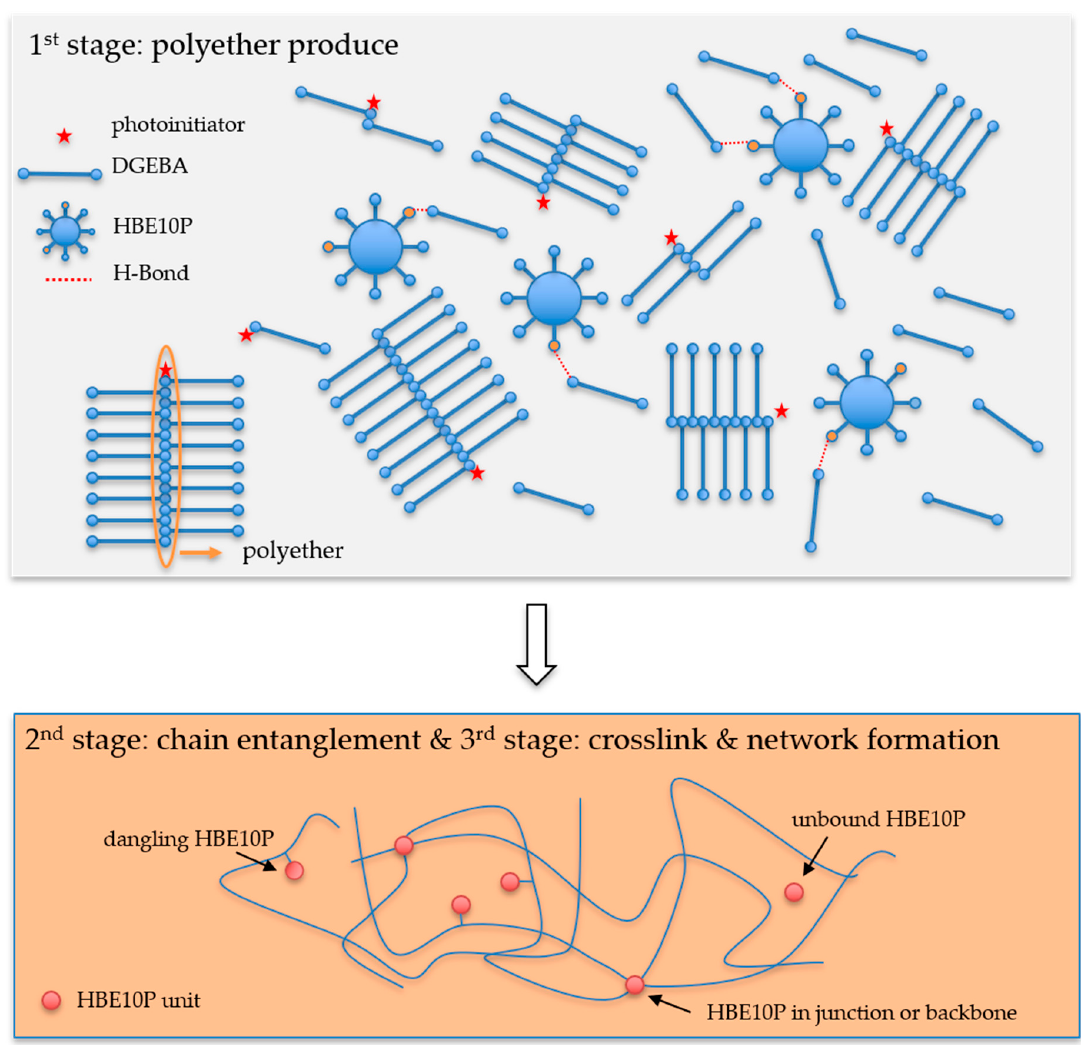
Figure 8. Scheme of UV curing reaction for DGEBA and HBE10P resins.